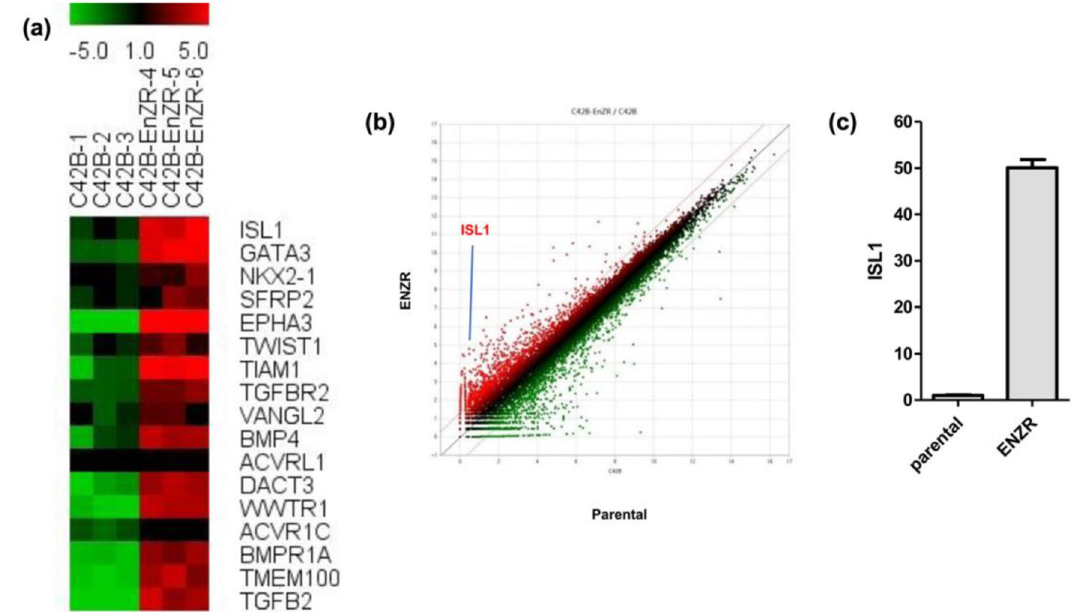
Figure 4. ISL1 is upregulated in enzalutamide-resistant (ENZR) prostate cancer. ( a ) Heat map of the most significantly differentially expressed epithelial mesenchymal transition genes from three independent experiments using the parental and enzalutamide-resistant C4-2B cell lines. Expression of transcripts encoding genes involved in EMT (epithelial mesenchymal transition) was analyzed by GSEA. Genes that were regulated twofold between C4-2B parental and enzalutamide-resistant C4-2B cells were enriched and heatmap was generated by TM4 Multi Experiment Viewer (MeV). GSEA, Gene Set Enrichment Analysis. ( b ) Scatterplot of transcript expression from the parental and enzalutamide-resistant C4-2B cell lines, with the position of ISL1 indicated. ( c ) The mRNA levels of ISL1 from the parental and enzalutamide-resistant C4-2B cell lines calculated from three different samples by RT-qPCR. Errors bars represent the mean ± SD of three independent experiments and * denotes p < 0.005 vs. the parental cell